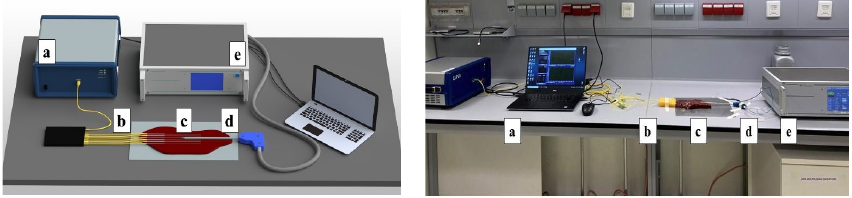
Figure 1. Schematic ( left ) and photographic view ( right ) of the radiofrequency ablation setup of the parenchymal tissue. The setup consists of: (a) OBR Luna 4600 with the computer used for data acquisition, (b) optical fibers, (c) bovine liver, (d) the RFA applicator, and (e) a hybrid RF/MWA generator used in RF mode.